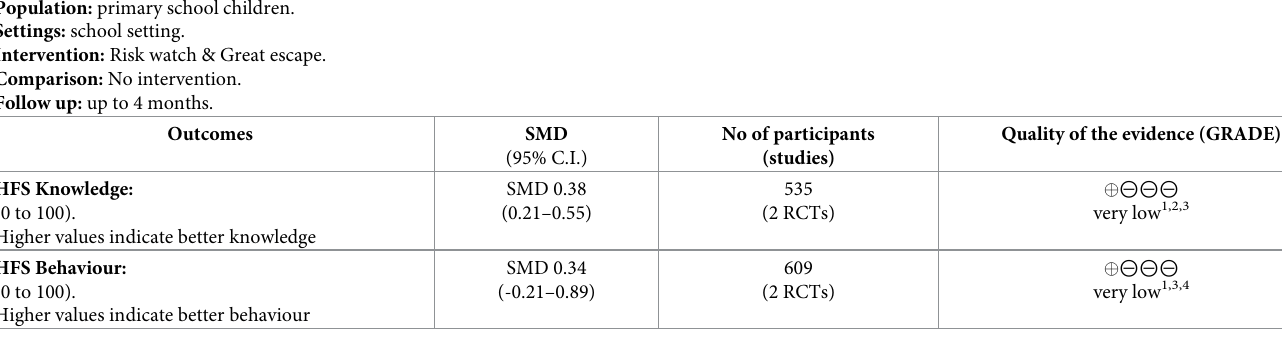
Table 4. Summary of findings. Intervention vs No Intervention. Population: primary school children. Settings: school